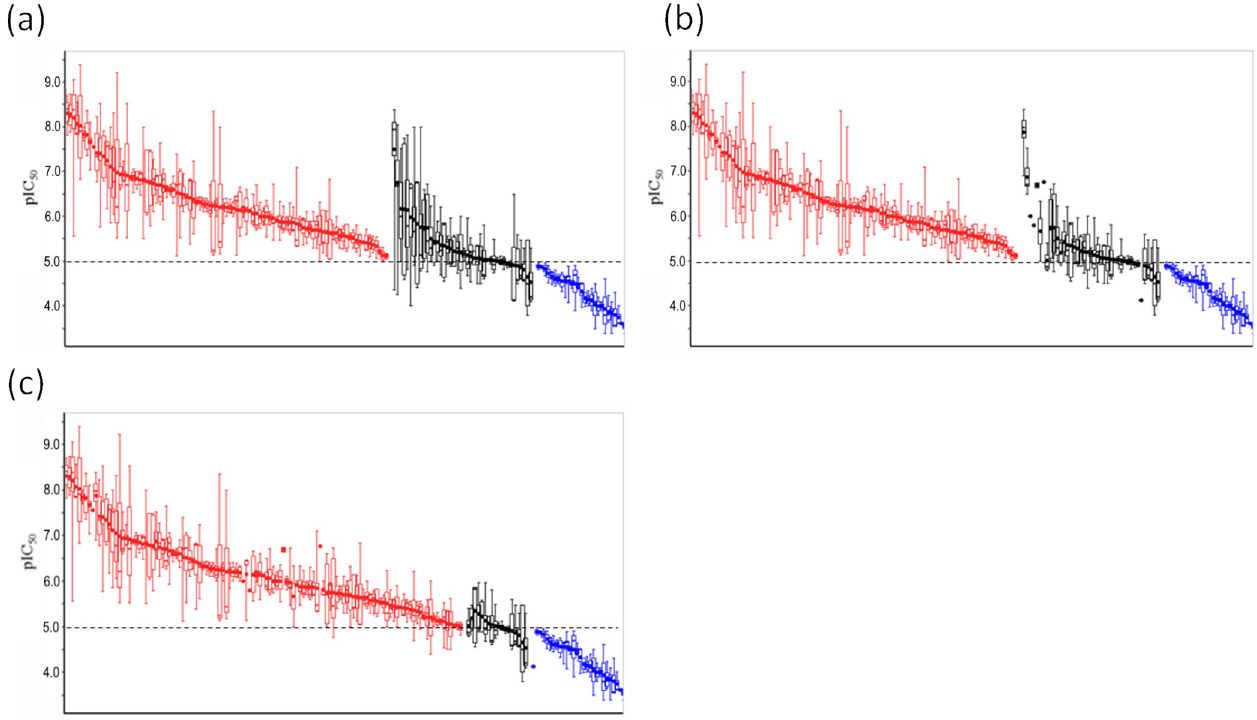
Fig 5. Step-wise procedure for compound classification. (a) Classification by unanimous results using all assay values. Positive, unclassified, and negative compounds are shown in red, black, and blue, respectively. The dashed line indicates the threshold value between positive and negative compounds (IC 50 = 10μM) (b) Distribution of assay values after removal of outlier values differing more than 10-fold from the mean IC 50 values from undefined compounds. (c) Classification by a two-thirds majority of filtered IC 50 values. The remaining unclassified compounds with nearly equal numbers of positive and negative assay results were considered as inconclusive compounds, and omitted from the subsequent analysis of physicochemical properties.